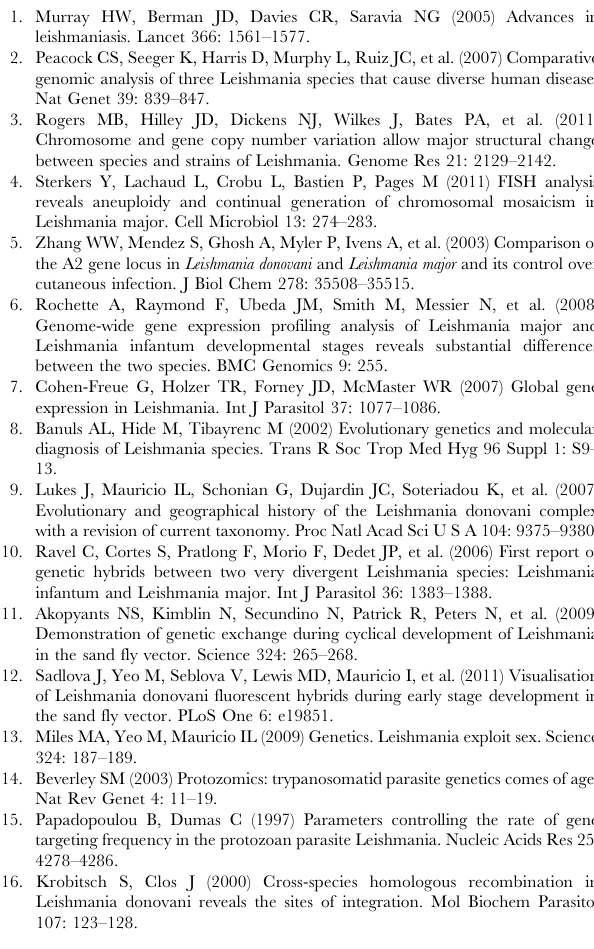
the size of exchanged DNA by sequencing. The SNPs found in the hybrid 263 (3) of Figure 3F are listed by their respective position in the gene. (DOC) Table S11 Loci analyzed by multilocus sequencing typing genes. Primers forward and reverse were used for both DNA amplification and sequencing (Table S2). The natural polymorphisms between L. major and L. infantum enabled mapping the size of exchanged DNA by sequencing. The SNPs found in the hybrid L. infantum 263 of Figure 5 are listed by their respective position in the